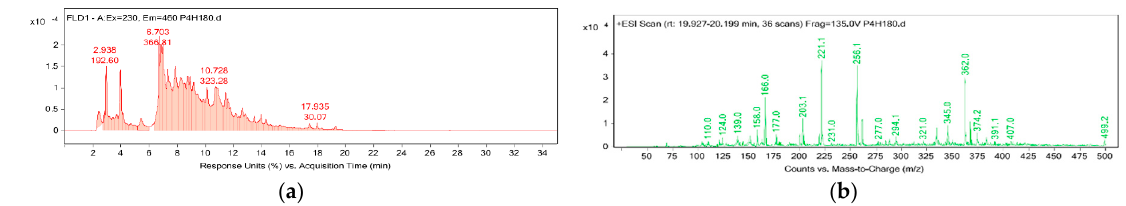
Figure 1. ( a ) HPLC-FLD-MS analyses of the liquid phase from the hydrothermal process and ( b ) MS spectrum of the humic